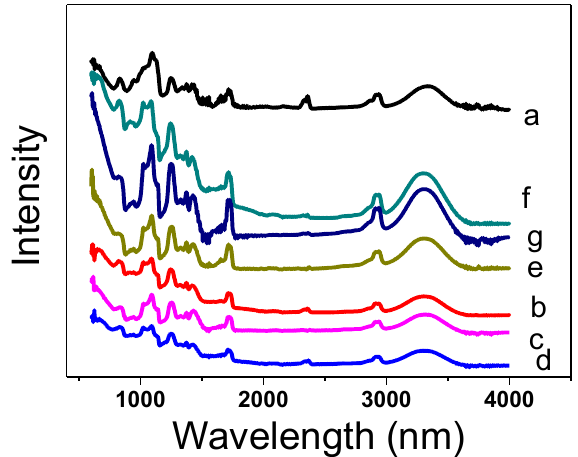
Figure 5. Fourier-transform infrared (FTIR) spectra of ( a ) Neat PVA nanofibers; ( b ) 5% PVA/ZnO nanofibers; ( c ) 7% PVA/ZnO nanofibers; ( d ) 9% PVA/ZnO nanofibers; ( e ) 5% PVA/TiO 2 nanofibers; ( f ) 7% PVA/TiO 2 nanofibers; ( g ) 9% PVA/TiO 2 nanofibers.